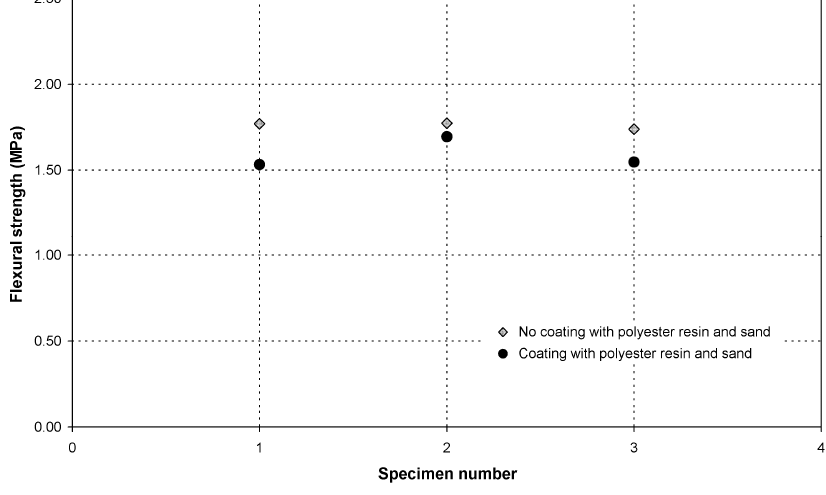
Figure 8. Flexural strength of the hollow tubes, maccherone shape, with and without polyester resin/sand coatings (black circles and grey diamond symbols,